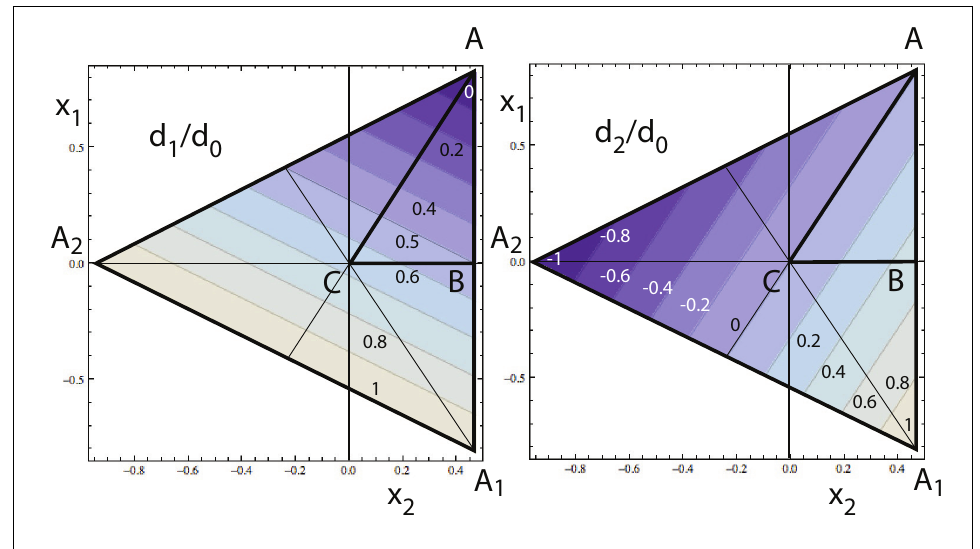
Figure 3. The state of depolarization in barycentric eigenvalue space for the coherency matrix associated with a Type-II canonical Mueller matrix as functions of the parameters d 1 / d 0 and d 2 / d 0 . If the eigenvalues are taken as ordered, the state is on or within the triangle ABC . For unordered eigenvalues, the state is on or within the equilateral triangle AA 1 A 2